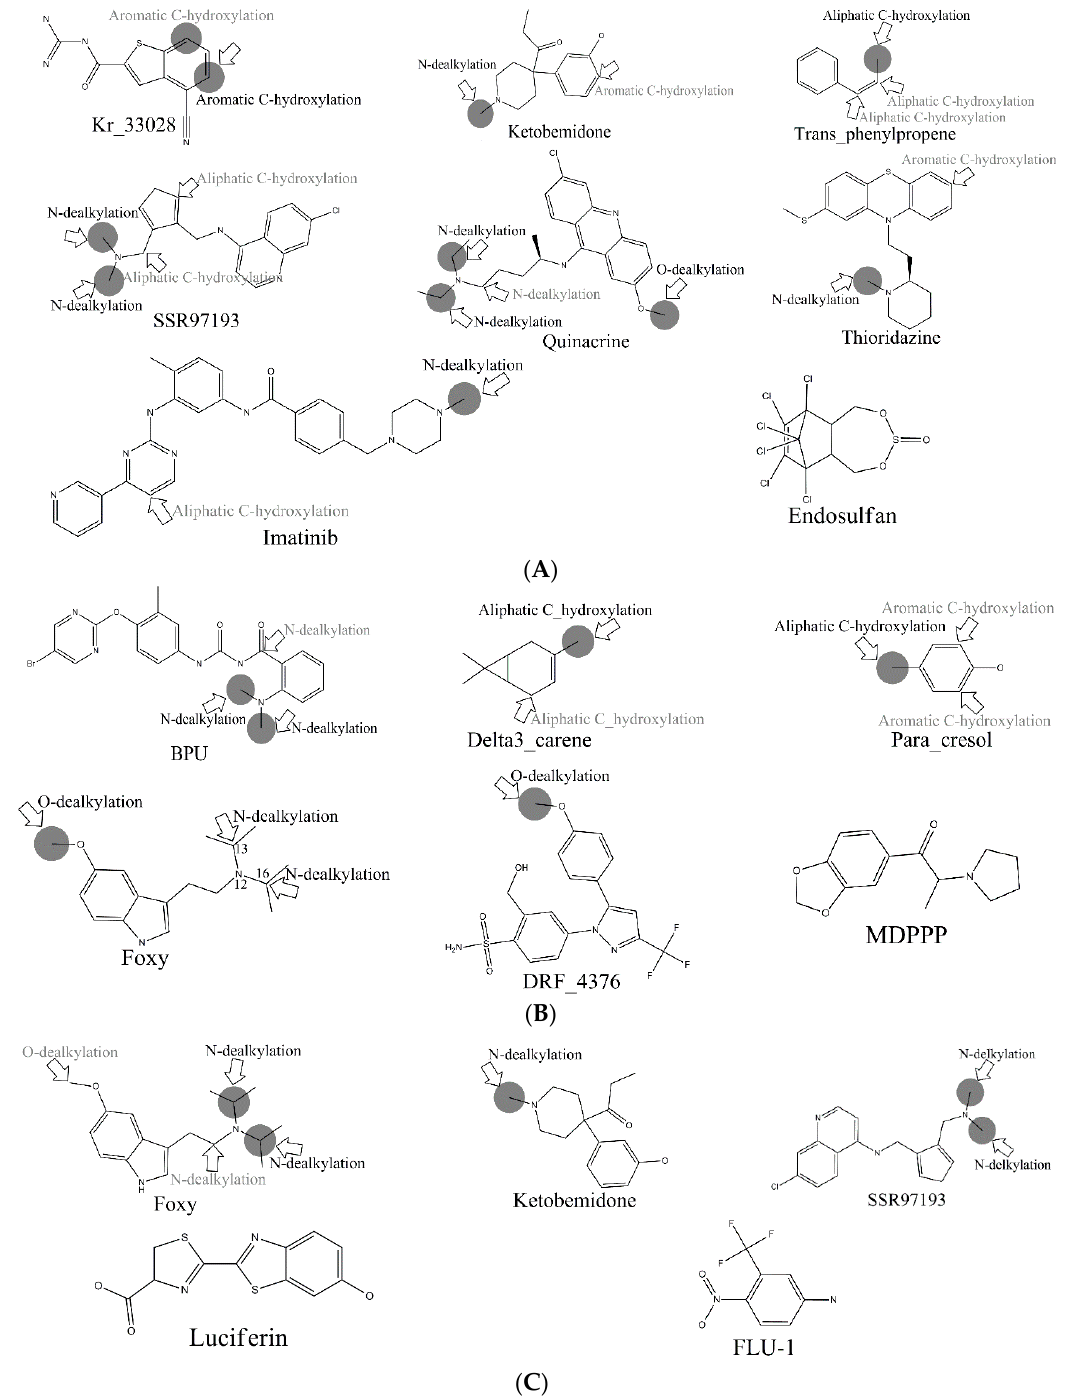
Figure 3. ( A ) CYP450 3A4; ( B ) CYP450 2D6; ( C ) CYP450 2C9. Example molecules in the external set that were well-predicted and poorly-predicted by full models established in this work. Experimentally observed SOMs are indicated with gray solid circles. Predicted SOMs with the microsomal metabolic reaction system (MMRS)-based prediction models are marked with hollow arrows where the designated biotransformations were also recorded. Noted are biotransformations marked with light gray—it is suggested that these SOMs were incorrectly identified. In contrast, black represents the SOMs correctly identified.